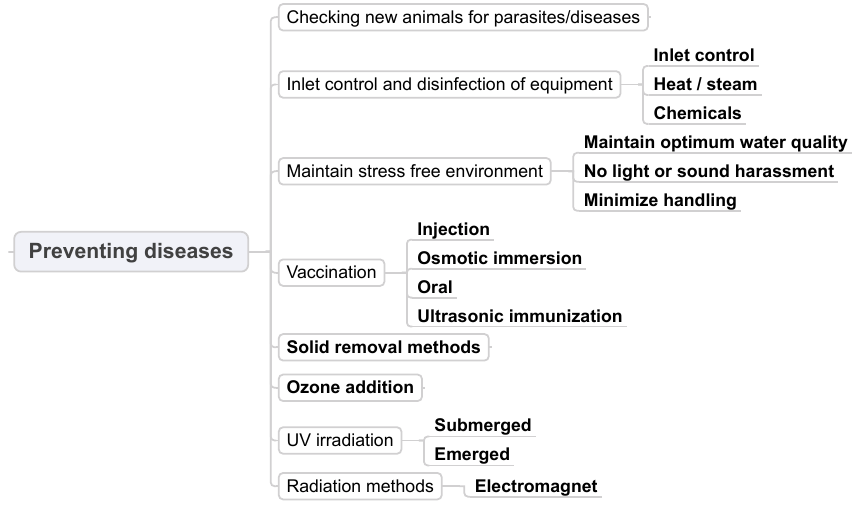
Figure 9. Taxonomy: preventing